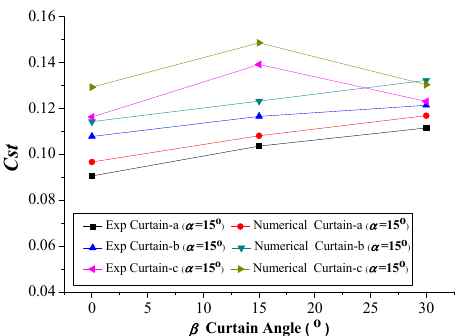
Figure 15. Static torque coefficients for different parameters ( θ = 150°).